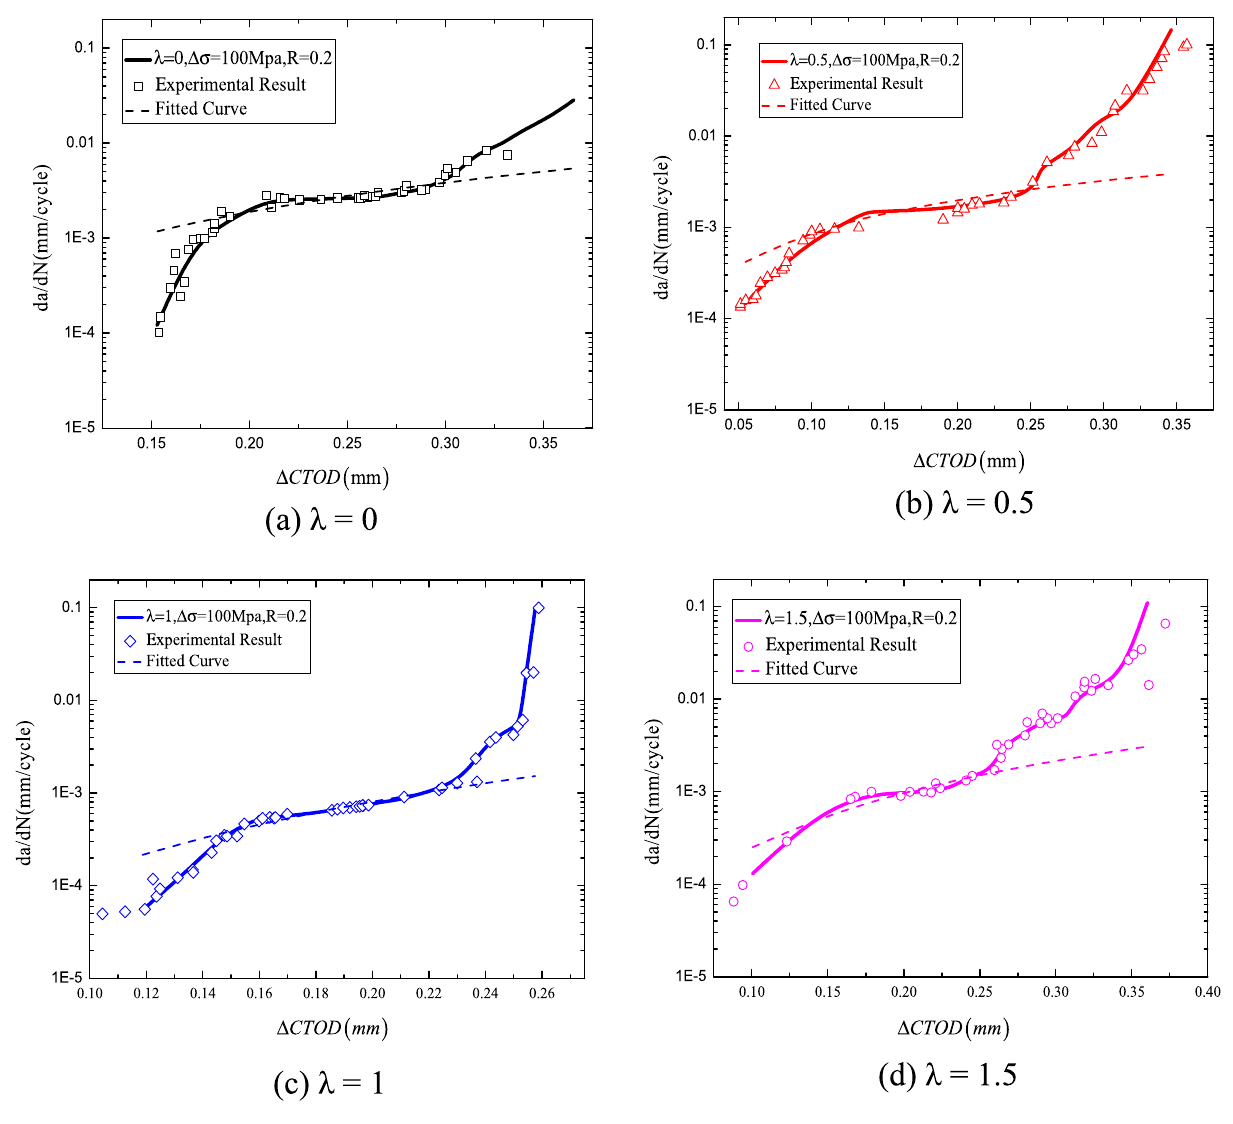
Fig. 13 Biaxial low-cycle fatigue crack growth curve for different biaxiality